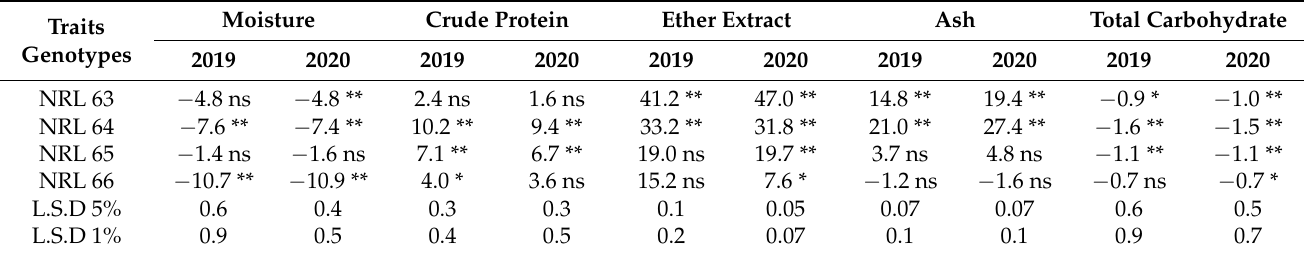
Table 13. Estimates of the percentage of advantage over commercial variety for chemical composition (%) of milled rice grains of the studied genotypes during the 2019 and 2020 growing seasons. Moisture Crude Protein Ether Extract Ash Total Traits Genotypes